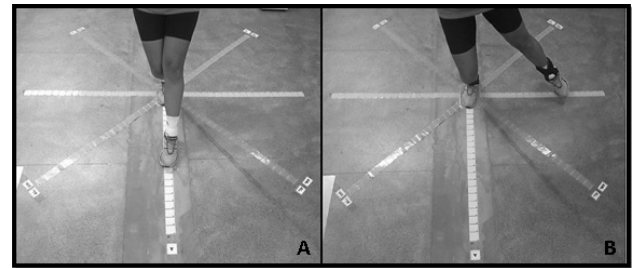
Figure 2. Execution in grid SEBT for dominant limb in the anterior (A) and medial (B) positions, considering the right lower